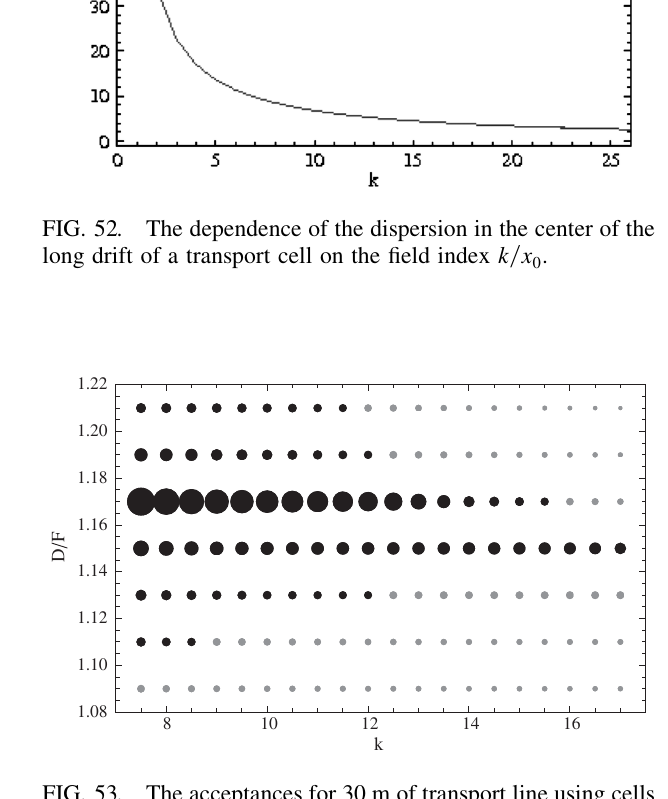
close to 0 ¼ 7 : 5 0